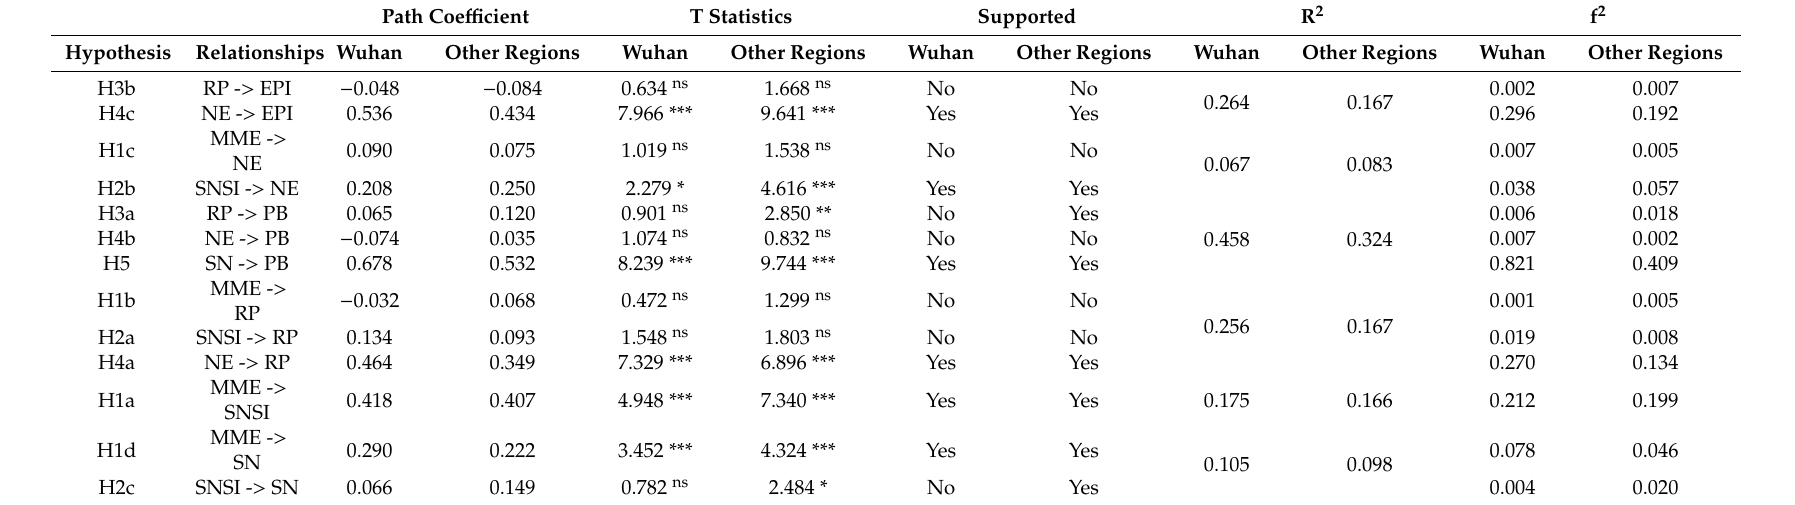
Table 7. Results for structural